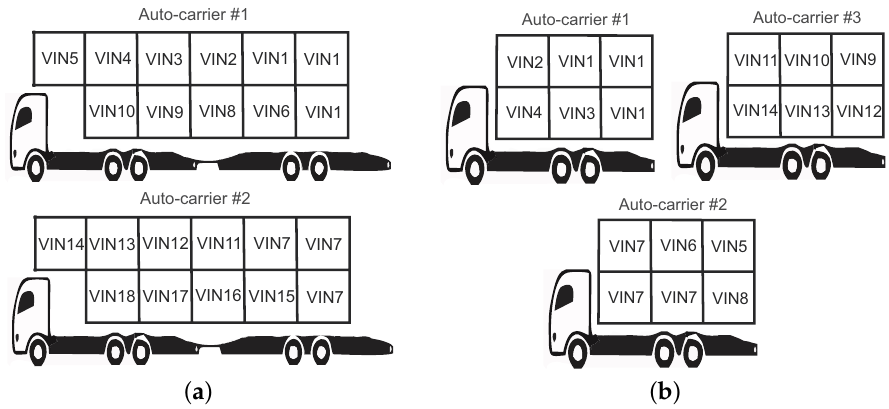
Figure 9. Output of vehicles allocation in auto-carriers: ( a ) Odd capacity ( b ) Pair capacity.